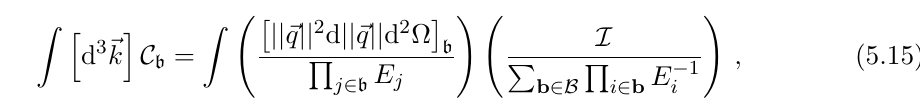
~k 2 (blue) and the channel j j I ~p 1 . Since the triangle has three (cid:0)